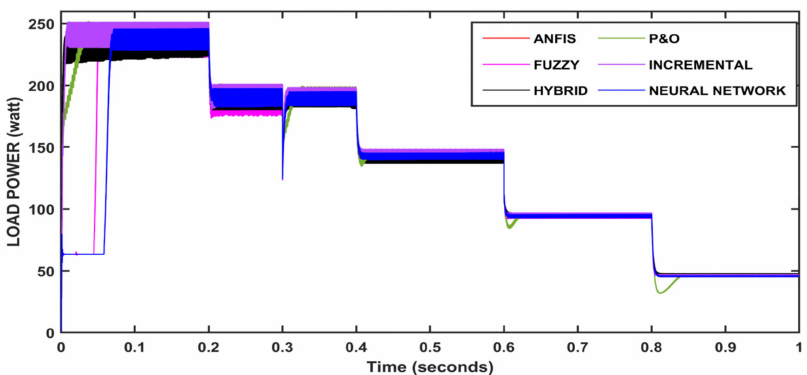
Figure 46. Controller performance at varying irradiations and varying